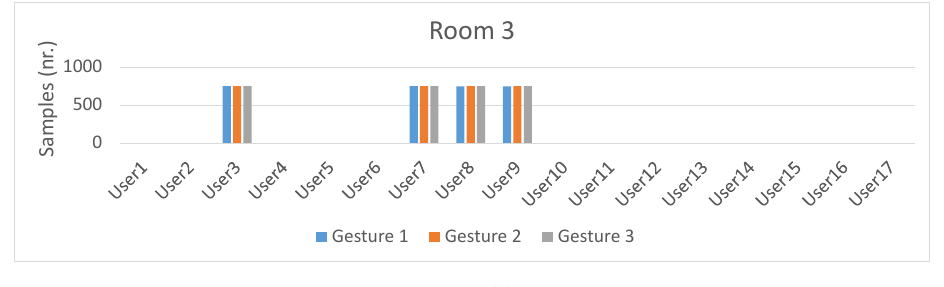
Figure 10. Data distribution of Widar3.0 dataset per subject in different rooms, taken from [5]. ( a ) Subjects in room 1; ( b ) Subjects in room 2; ( c ) Subjects in room 3.